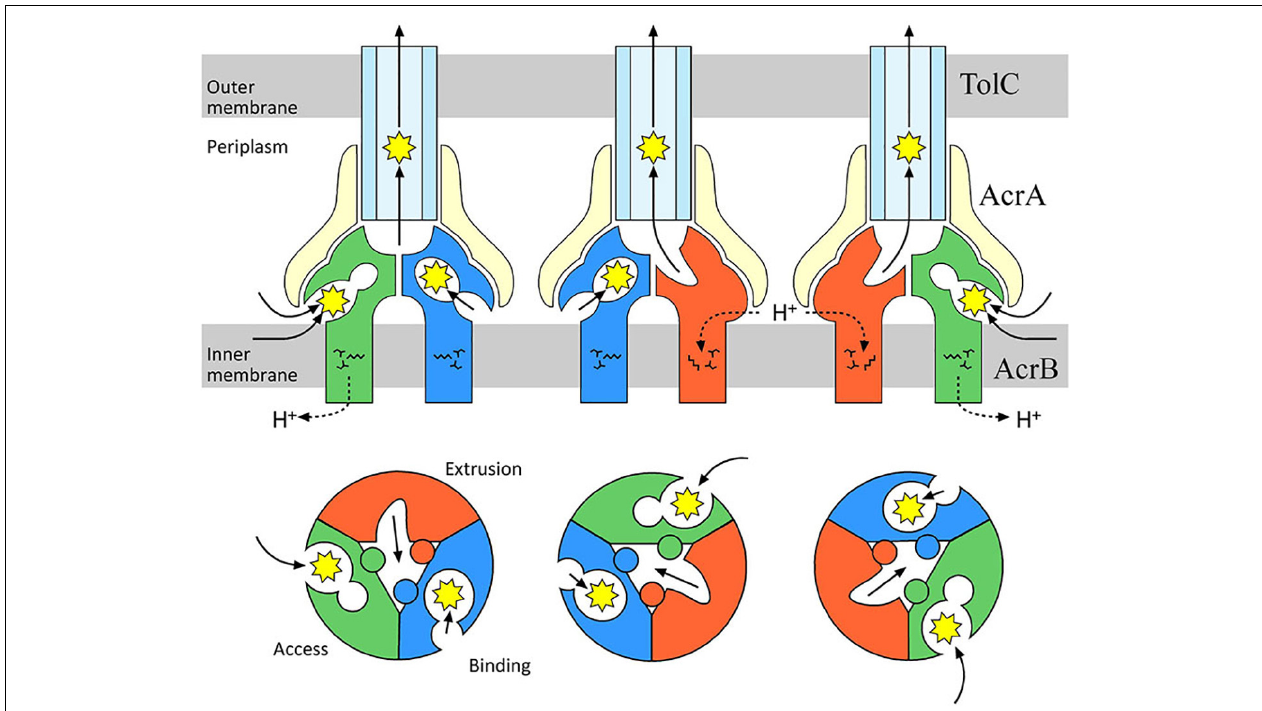
FIGURE 10 | Drug transport via the AcrAB-TolC multidrug efflux system. AcrB facilitates the proton motive force as its energy source to extrude drugs from the periplasm or inner membrane to the outside of the cell. During drug-transport, each monomer of the AcrB trimer has a different structure. Drugs are transported in sequence from the Access to the Binding monomer, and then to the Extrusion monomer. We found a drug-recognition pocket near the entrance called the Proximal Binding Pocket (PBP, expanded in the Access monomer), and a Distal Binding Pocket (DBP) near the exit (expanded in the Binding monomer). Erythromycin (molecular weight: 734 g mol − 1 ) and rifampicin (molecular weight: 823 g mol − 1 ), two drugs with a relatively large molecular weights, temporarily bind to the PBP, then they are sent to the DBP via a peristaltic pump mechanism (Nakashima et al.,